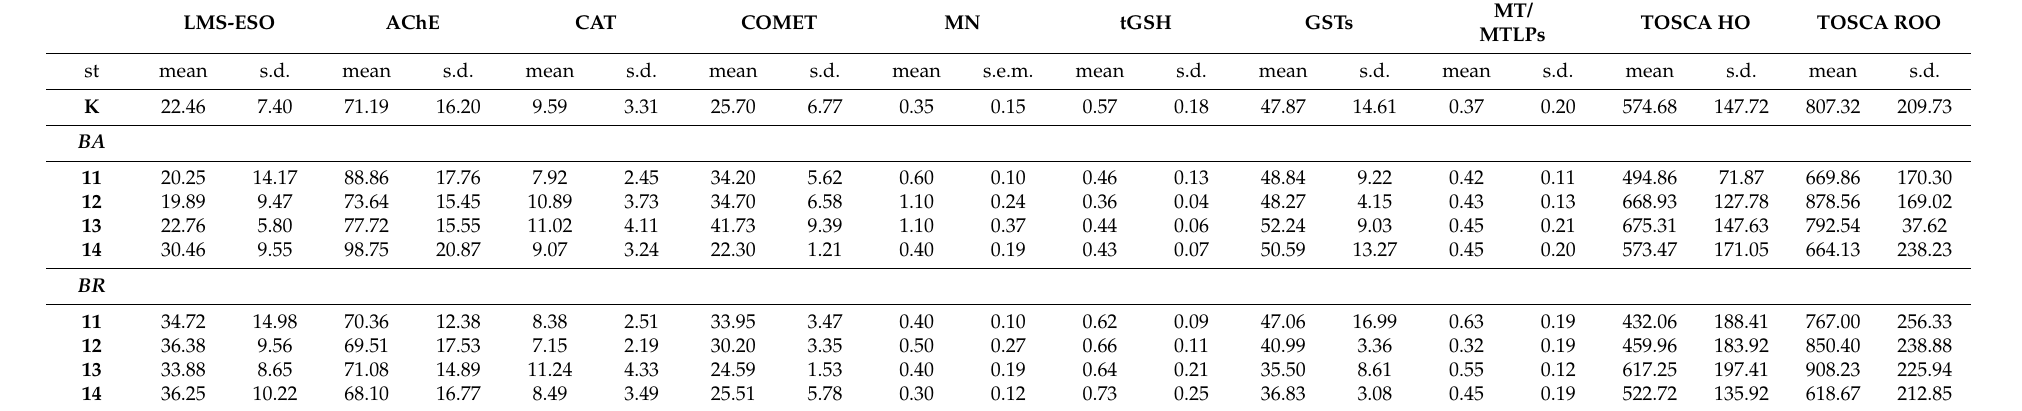
Table 4. The results of biomarker analyses in Hediste diversicolor exposed to sediment sampled around offshore platforms called BA and BR and control area K. Mean ± standard deviation (s.d.) or standard error (s.e.m.). N = 10.